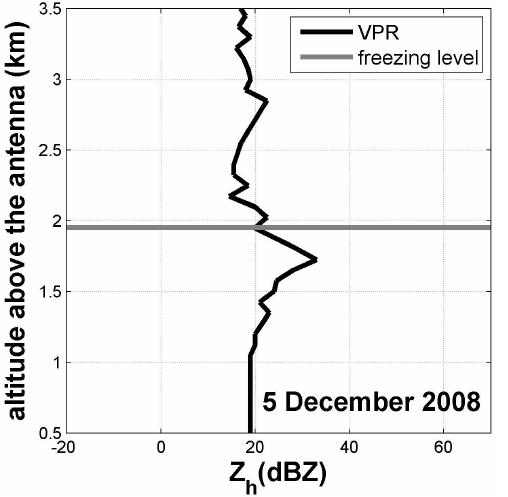
Fig. 11. Reflectivity trend with altitude (km) and 0 ◦ C isothermal height at 15:40 p.m., both relative to the stratiform part of the con- vective event of 5 December 2008.